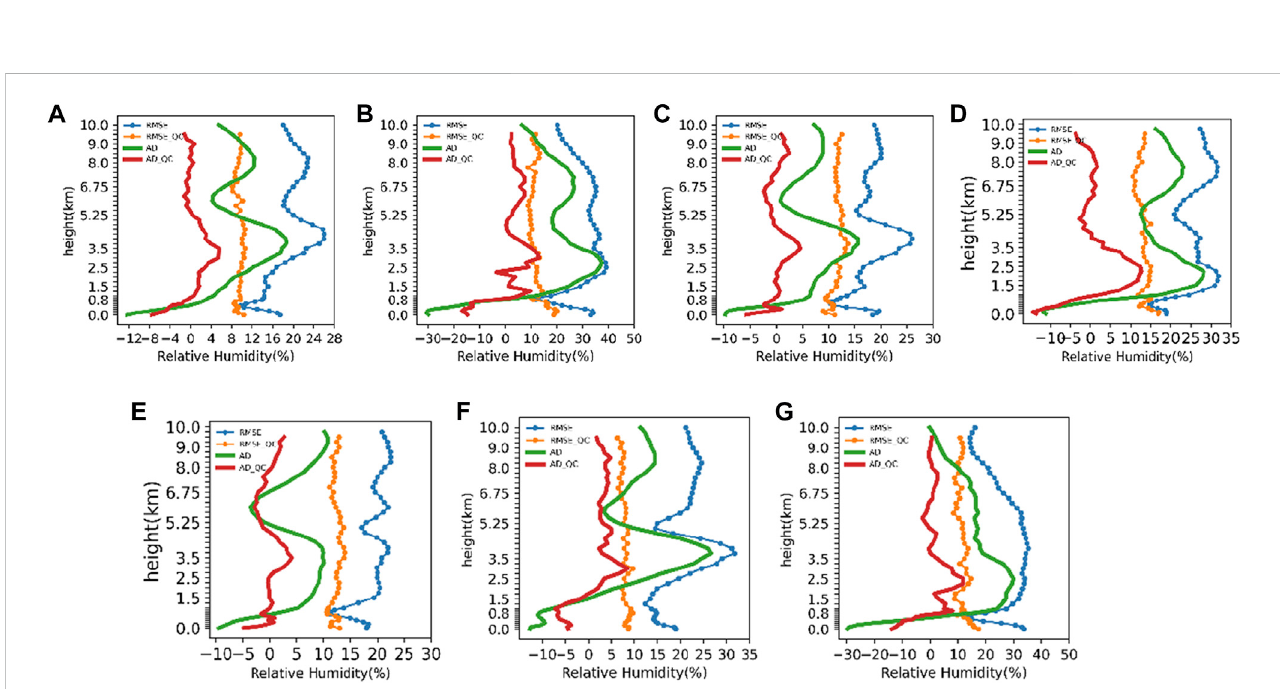
FIGURE 3 Average deviation (AD, red and green lines) and RMSE (blue and yellow lines) of relative humidity (%) betweensounding and MWR observations atstation (A) 54399, (B) 54406, (C) 54419, (D) 54421, (E) 54424, (F) 54511, and (G) 54597. RMSE_QC and AD_QC are the RMSE and AD after data quality control,